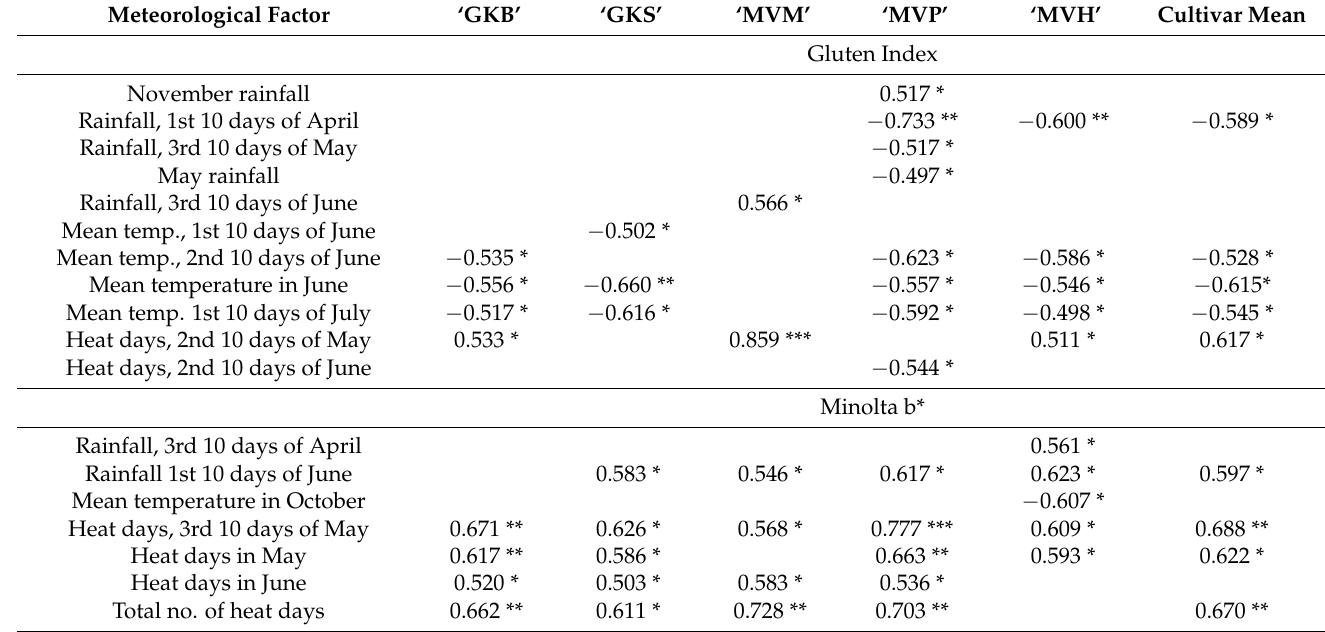
Table 3. Pearson’s correlation coefficients between meteorological factors and the gluten index and Minolta b* values of the five durum wheat genotypes over 16 years. *, ** and *** denote significant differences at the p < 0.05, 0.01 and 0.001 levels of